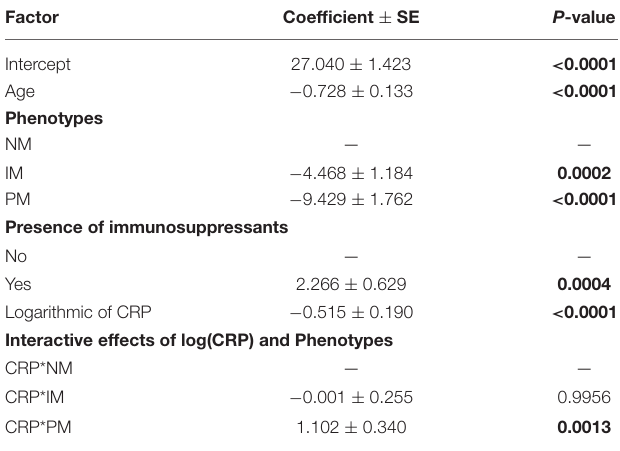
TABLE 3.2 | Multivariate linear mixed-effects regression analysis of the influence of covariates on voriconazole dose required to achieve therapeutic range (mg/kg).